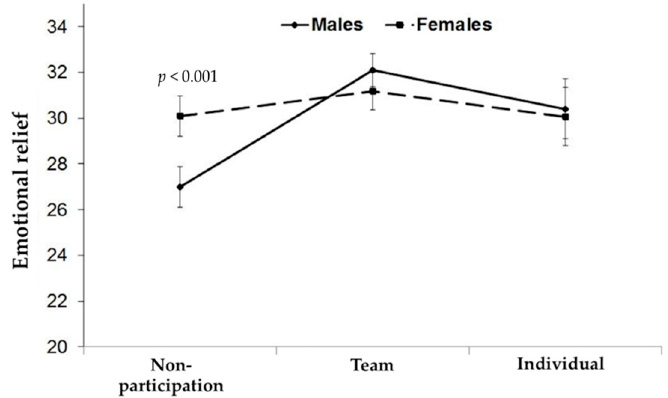
Figure2. E ff ectsof genderandsport typeonemotional relief intheKoreanDrinking RefusalSelf-E ffi cacy Figure 2. Effects of gender and sport type on emotional relief in the Korean Drinking Refusal Self- (DRSE) questionnaire. Efficacy (DRSE) questionnaire.